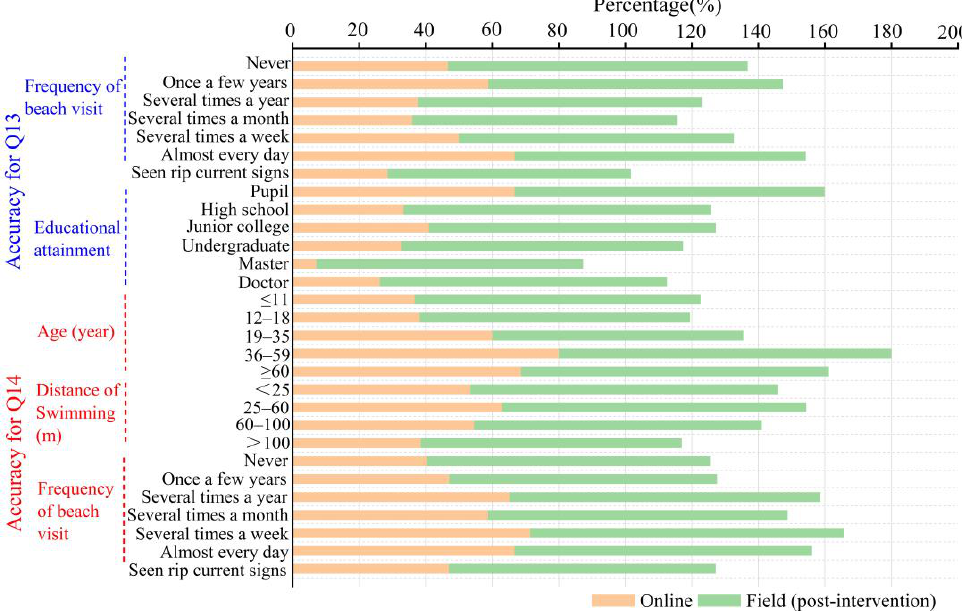
Figure 9. Influence of age, educational attainment, frequency of beach visit, swimming ability, and whether or not they have seen warning signs of rips on network and field respondents’ identification of rip current on actual beach scene and escape direction selection.